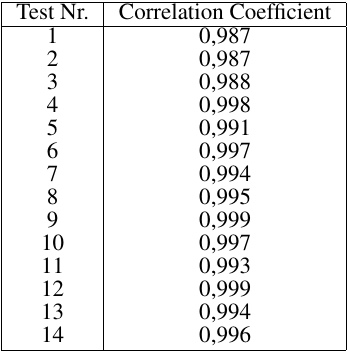
Table 1. Correlation coefficients between the mean DolP time series and the linearized weight time series for each test in the last 60 minutes with a mean correlation coefficient of 0.994 for all